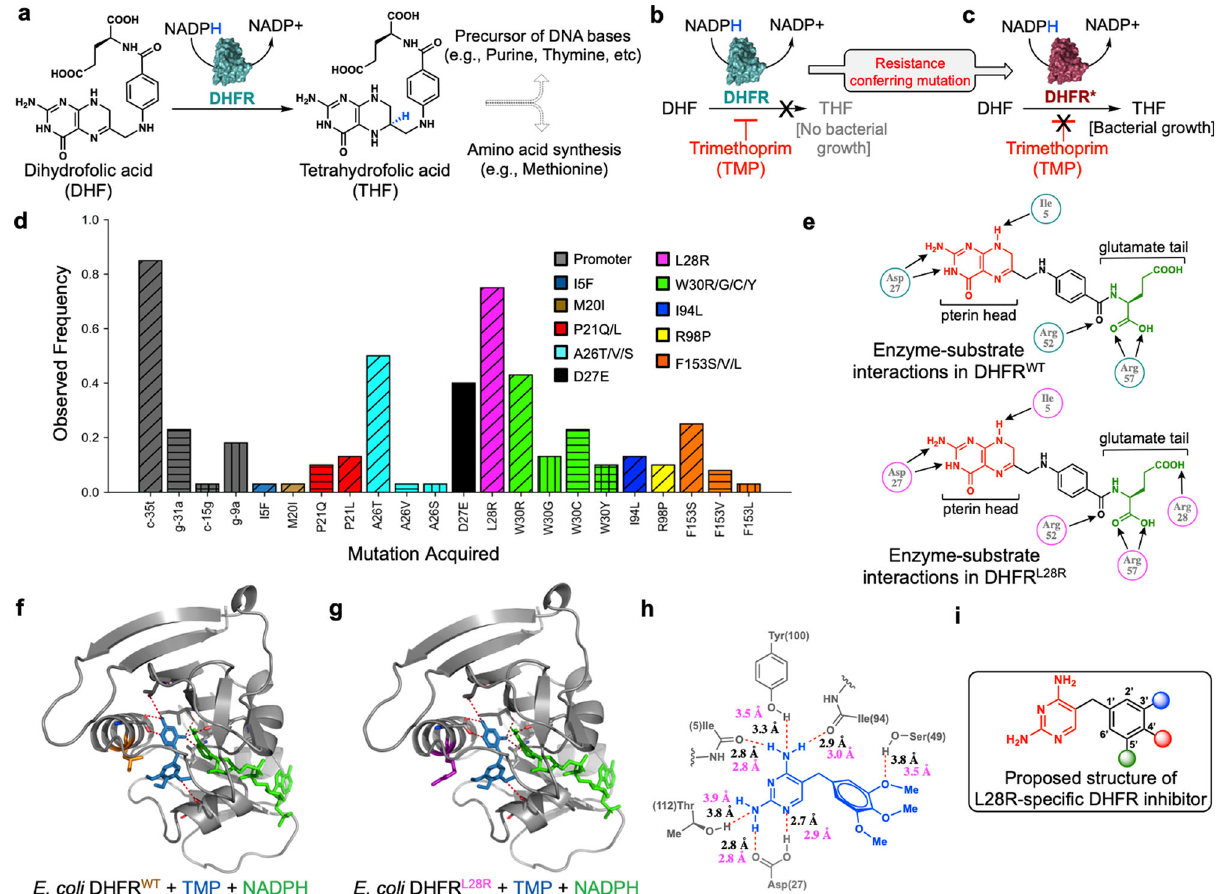
Fig. 1 L28R is a coding mutation in E. coli DHFR with a unique resistance-conferring mechanism. a DHFR is an essential enzyme with a central role in the biosynthesis of nucleotides and amino acids. b Trimethoprim (TMP) is a bacteriostatic antibiotic molecule that competitively inhibits DHFR activity. c Resistance-conferring DHFR mutations that reduce TMP af fi nity are responsible for the evolution of TMP resistance in E. coli . As TMP is a competitive inhibitor of DHFR, resistance-conferring mutations typically reduce both TMP and substrate (DHF) binding af fi nities. d Frequencies of resistance-conferring DHFR mutations from 40 independent E. coli populations evolved in the morbidostat under TMP selection [7 populations from this study (Fig. 4) and 33